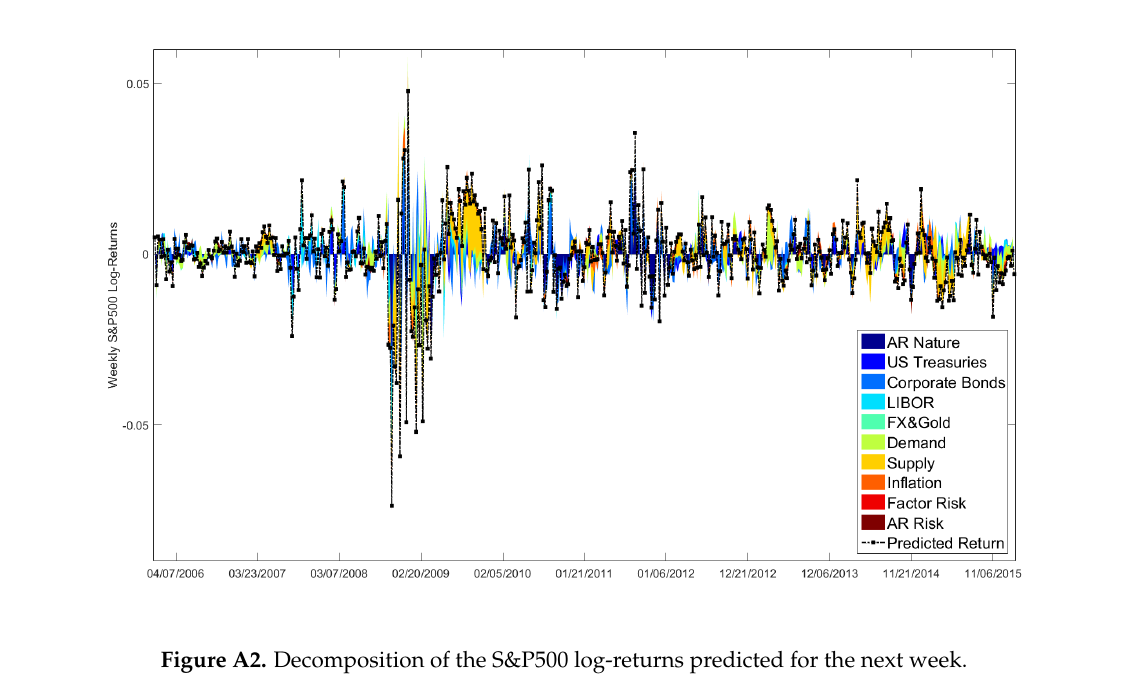
Figure A1. Prediction intervals for S&P500 log-returns of the subsequent week (gray and black areas) and afterwards realized S&P500 log-returns (red line). The light gray area reveals the 50%-prediction intervals, whereas the black areas define the 90%-prediction intervals. Here, the prediction level gradually increases by 10% for each new, slightly darker area.